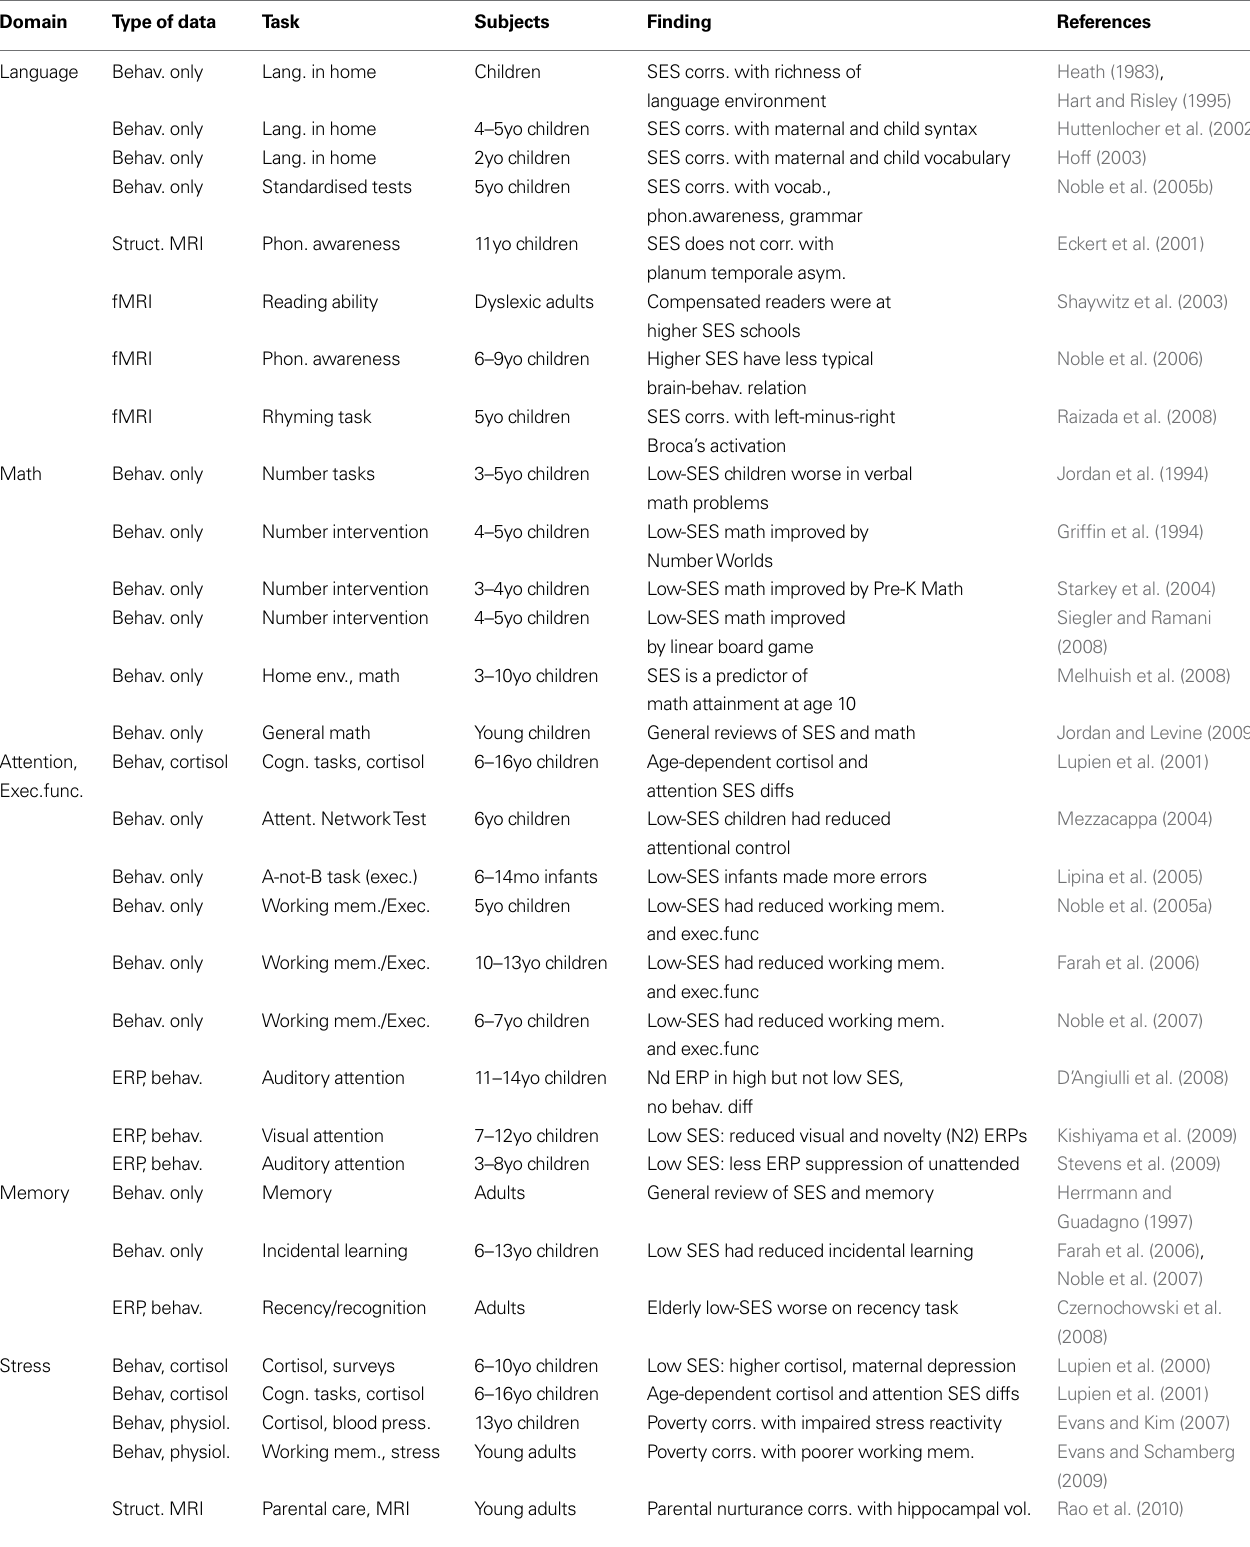
Table 2 | Some of the main experimental fi ndings on SES and cognitive development. From the very small number of neural studies, together with the large number of behavioural fi ndings, it can be seen that there are great opportunities for new